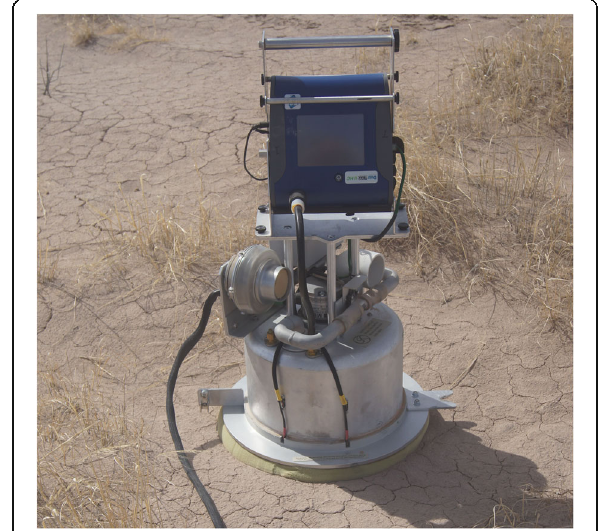
Fig. 3 PI-SWERL in test configuration on an undisturbed surface at the eastern beach area